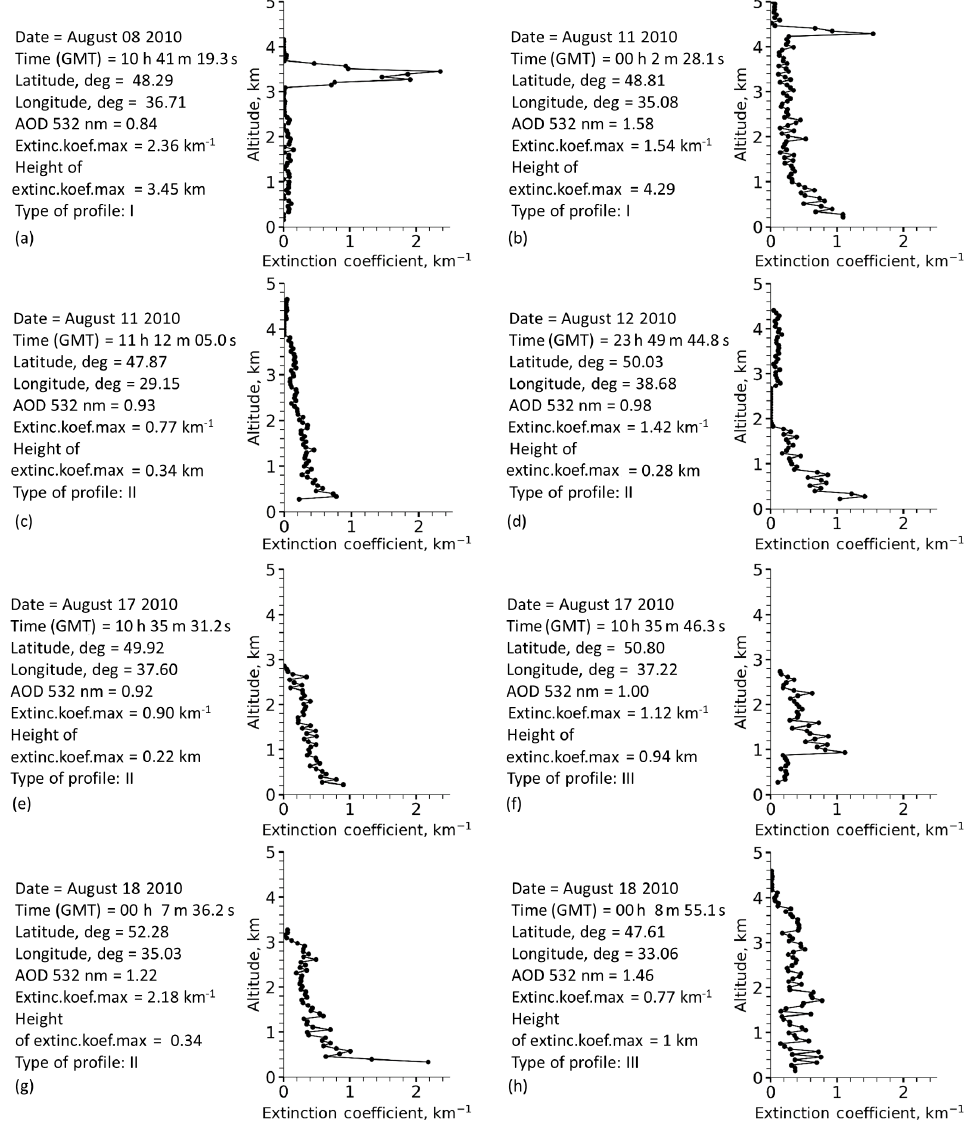
Figure 9. Selected vertical profiles of aerosol extinction coefficient from CALIOP measurements over Ukraine during active fires period in summer 2010. The location of profiles is shown in Fig. 8b with corresponding a–h